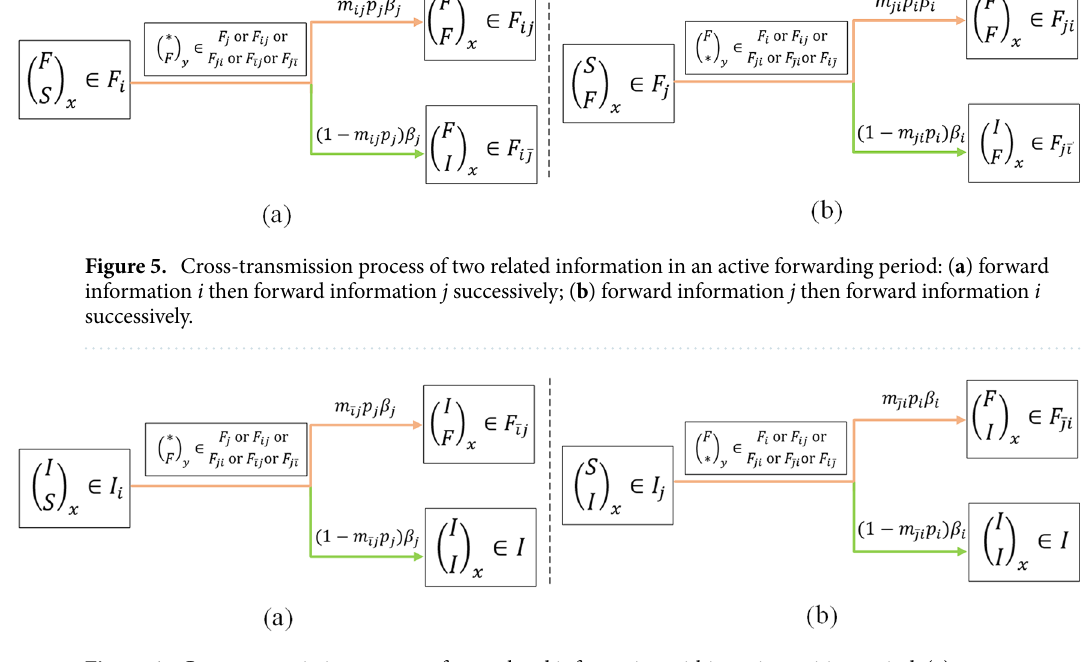
Figure 6. Cross-transmission process of two related information within an insensitive period: ( a ) contact information i then forward information j ; ( b ) contact information j then forward information i